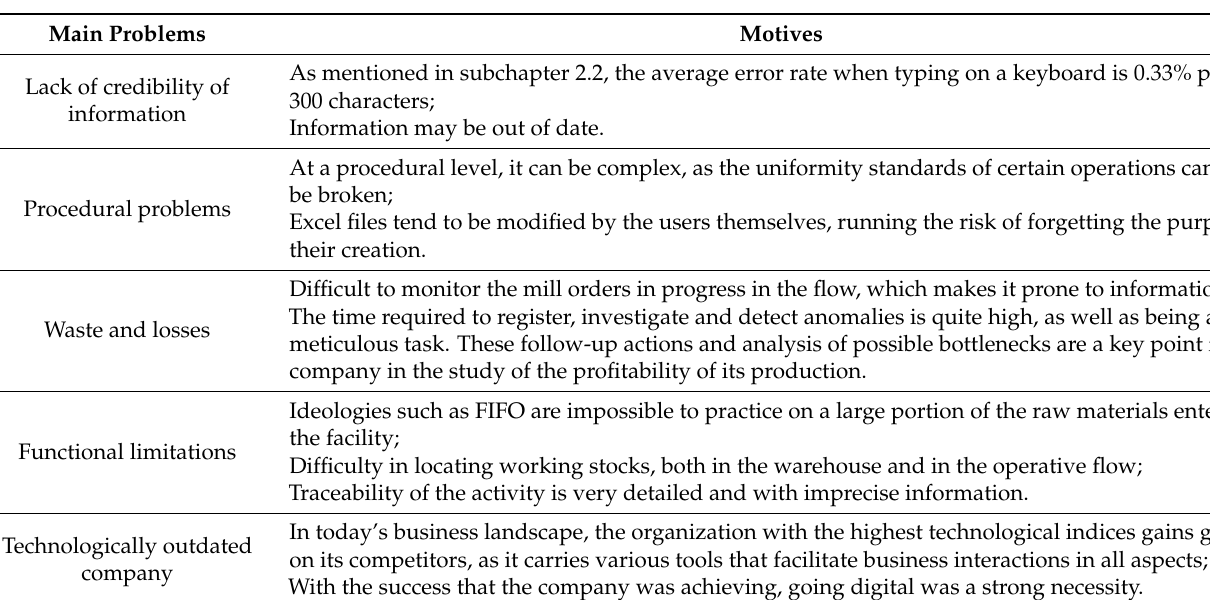
Table 5. Traceability gaps in the production